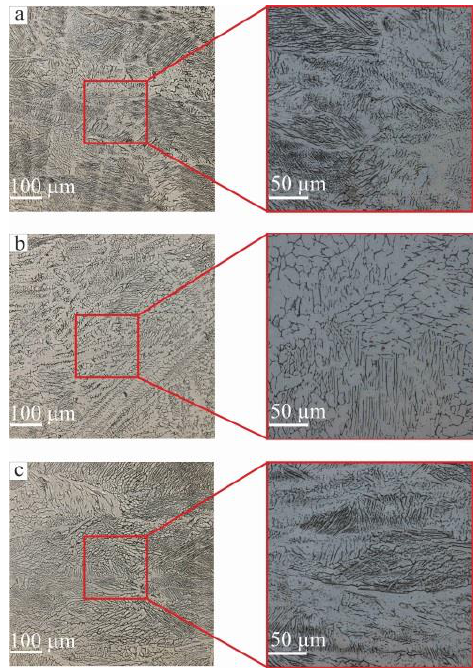
Figure 6. Optical microscopy of steel areas: ( a ) zone I; ( b ) zone III; ( с ) zone V. The morphology of the grain–dendrite structure of stainless steel areas.